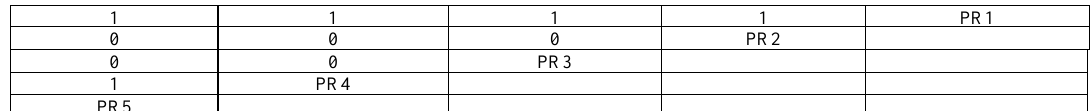
Table 6. Self-interaction binary matrix for process in binary form.